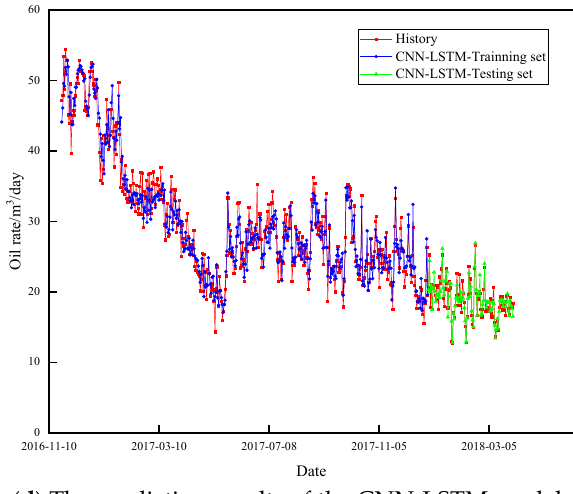
( d ) The prediction results of the CNN-LSTM model. Figure 8. Fitting effect of four models’ prediction results. The relative error analysis between the testing results of ANN, decline curve analysis, RNN, LSTM and CNN-LSTM models and the real values is shown in Figure 9. For the results of ANN and RNN, multiple error values are distributed beyond 20%, some errors will be close to 60–80%. For LSTM and decline curve, although the error is obviously smaller than that of traditional neural network, there are still some error points close to 60%. As for CNN-LSTM, most errors are within 20%, and individual error points fall within 20–40%. Through comparison, it can be concluded that the proposed model can accurately predict the global trend and local single value of oil production time series.